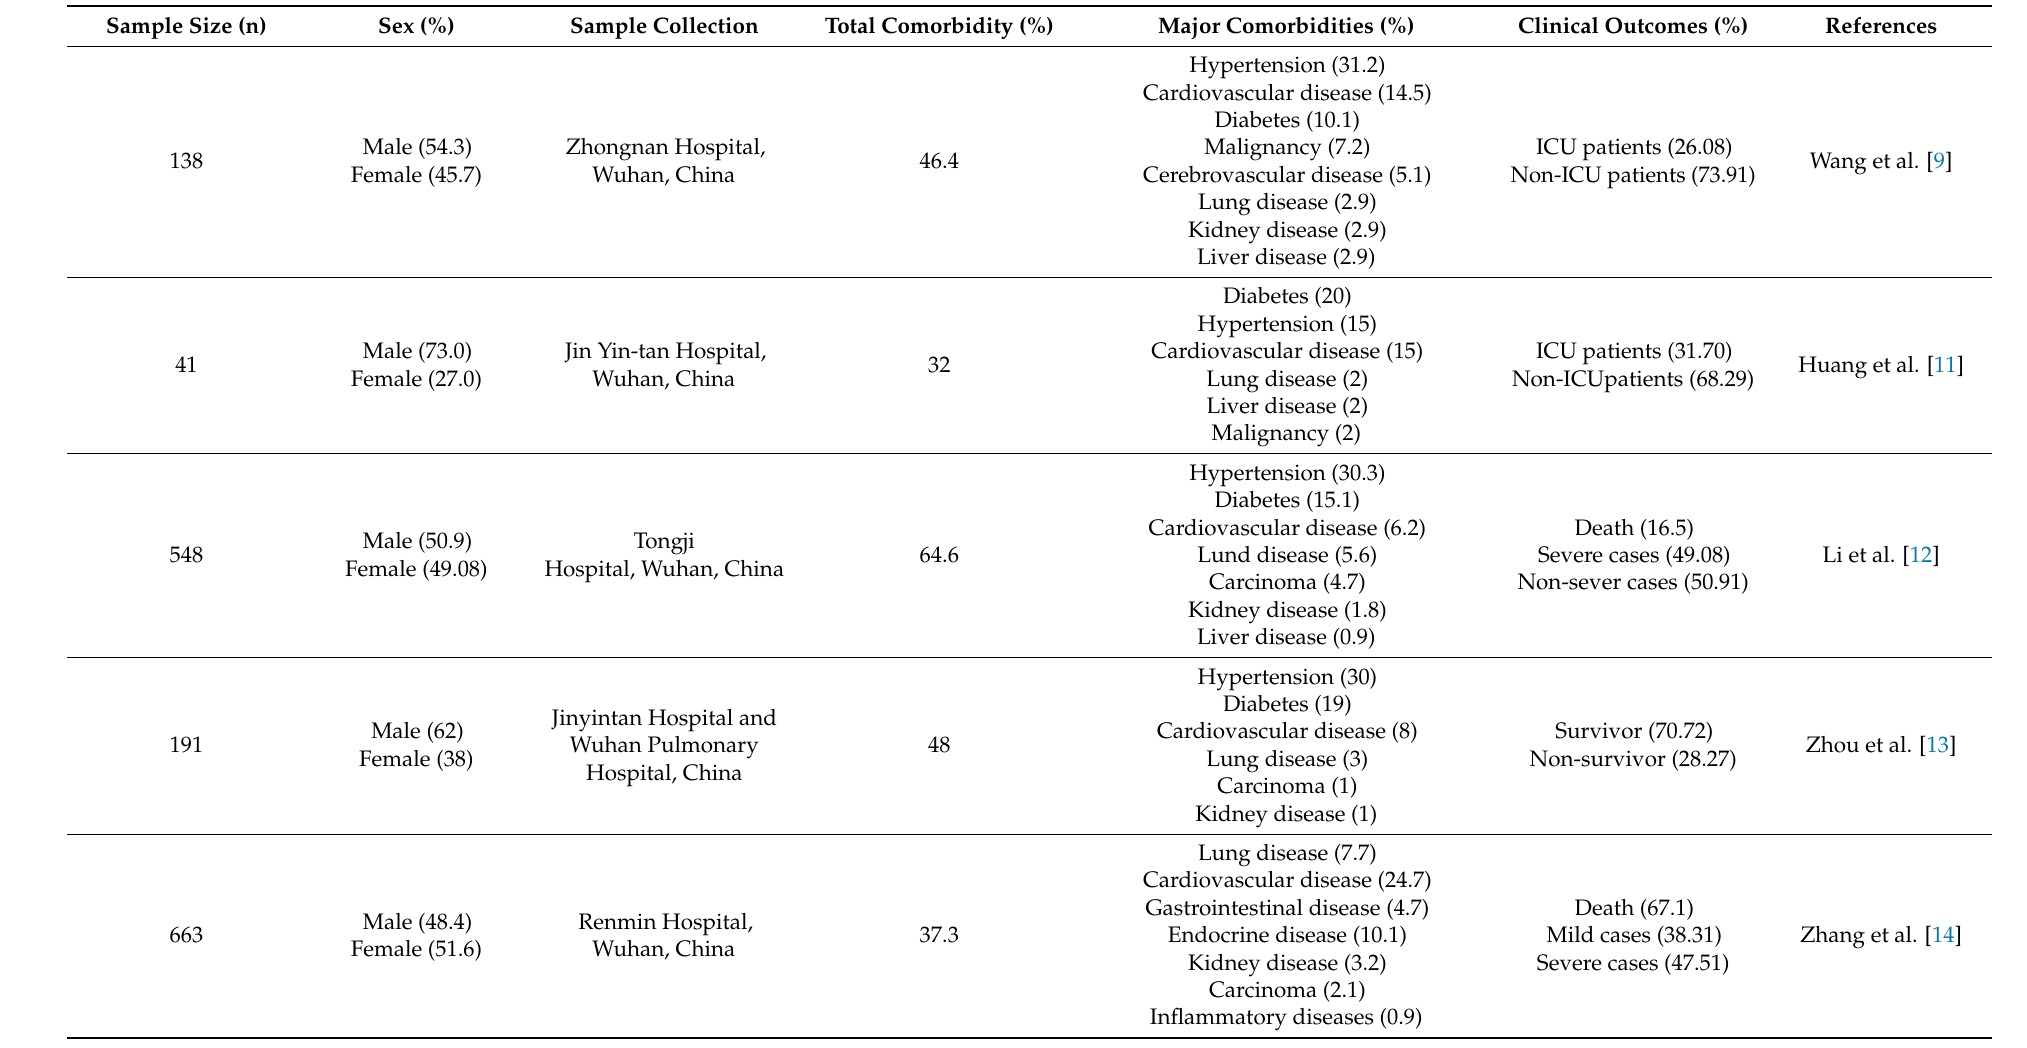
Table 1. Selected clinical studies on major comorbidities of COVID-19 and clinical